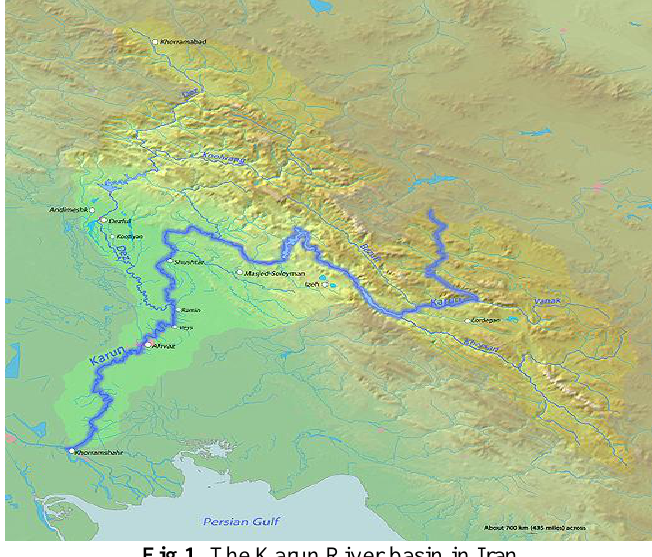
Fig.1. The Karun River basin in Iran Table1. Summary of applied data in calculations of total and suspended sediment load in Karun River